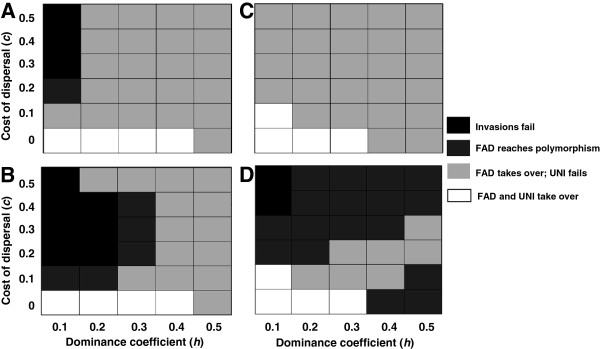
FAD facilitates the evolution of increased dispersal rates. Each cell shows the outcome of invasions of FAD or UNI modifier alleles. Modifier alleles are introduced at 50% to a population dispersing at a uniform rate of α = 0.3 (A and B) or α = 0.1 (C and D). If both FAD and UNI invasions were significantly more successful than expected by a neutral allele, the cell is white. If no strategy was successful, the cell is black. If only FAD was successful, the cell is light grey. If FAD was maintained at polymorphism but did not take over, the cell is dark grey. FAD facilitates the evolution of increased dispersal rates of α = 0.4 (A), α = 0.5 (B), α = 0.2 (C) and α = 0.3 (D) under a wider parameter range than UNI. The difference is particularly noticeable when there is a cost to dispersal (c > 0) and when the masking of deleterious alleles is not very low (h > 0.1). Qualitatively identical results were obtained for the introduction of FAD alleles at a frequency of 0.01 for a sample of the parameter range.